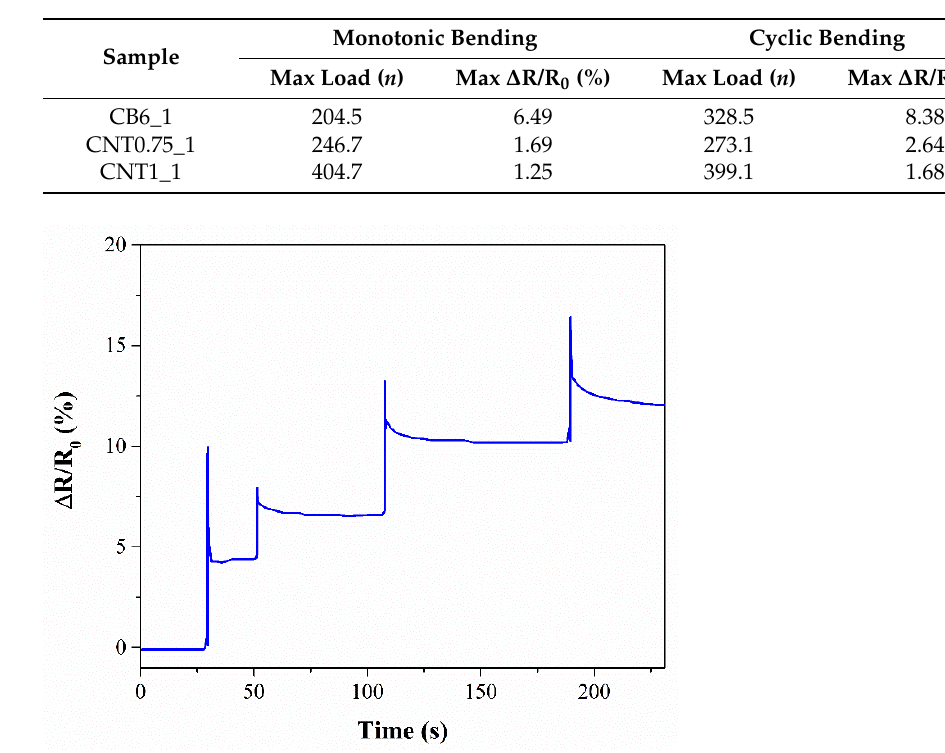
Figure 8. Self-monitoring behavior of ( a ) CB6_1, ( b ) CNT0.75_1, ( c ) CNT1_1, and ( d ) CNT0.75_2 under cyclic bending tests. Table 4. Mechanical and self-monitoring properties of CB and CNT systems.